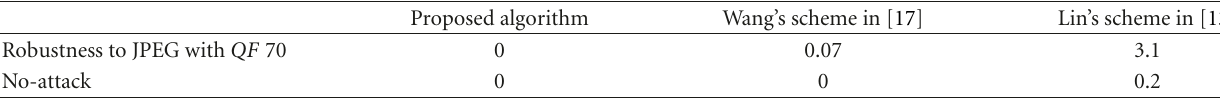
Table 9: Comparisons with some content-based watermarking methods ( P fp